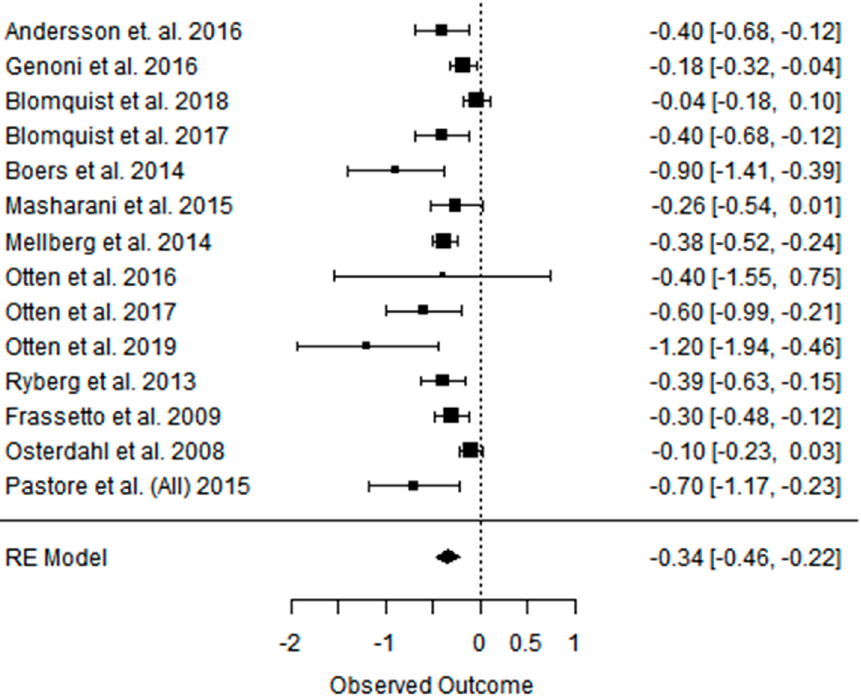
Figure A17. Forest plot of the effect of a PDs on TG in the short term (weighted mean difference).